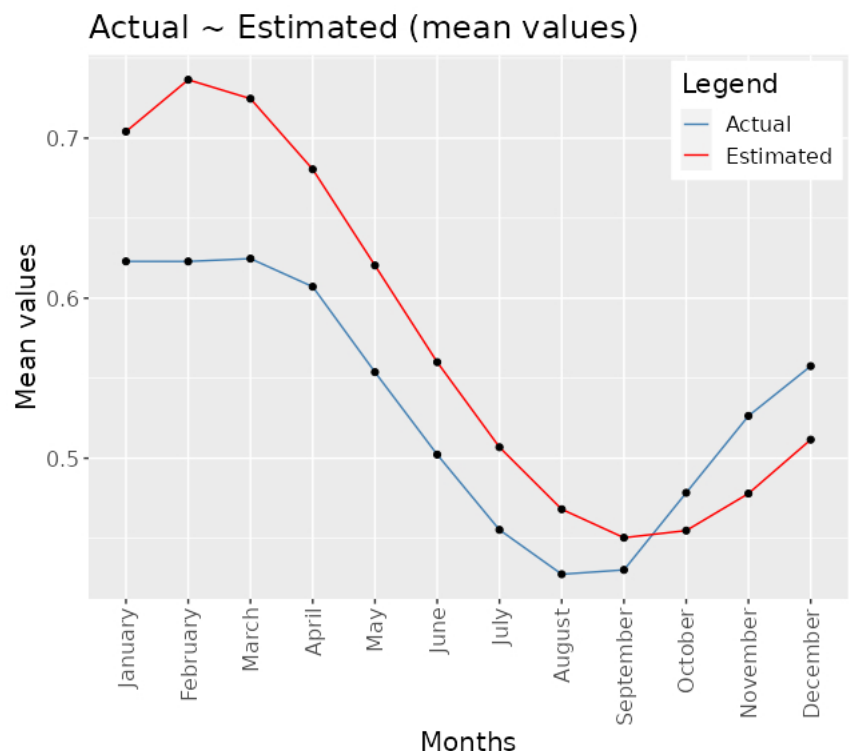
Figure 11. Monthly differences between estimated and predicted NDVI values. For each month, the mean value for the study area was calculated.